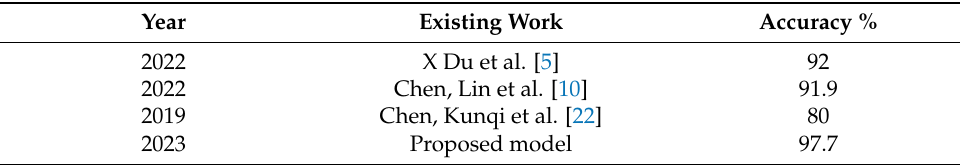
Table 6. Comparison analysis of the proposed model.